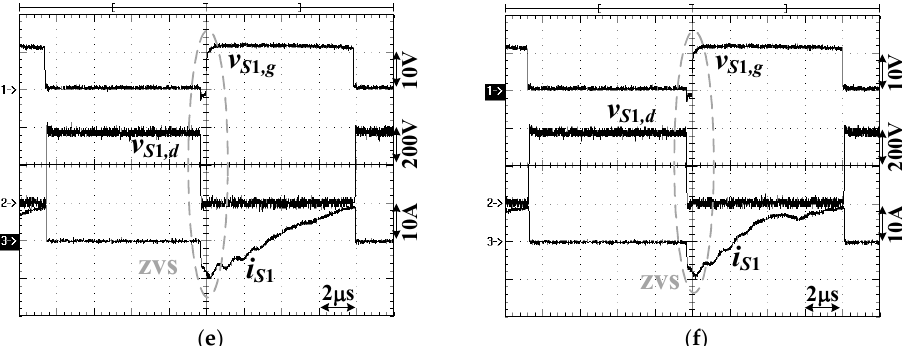
Figure 11. Experiments of the presented converter under V o = 160 V: ( a ) v S 1 ,g , v S 2 ,g , v S 3 ,g , and v S 4 ,g under V in = 760 V and P o = 1 kW; ( b ) v S 1 ,g , v ab , and v bc under V in = 760 V and P o = 1 kW; ( c ) v Cr 1 , v Cr 2 , and i Lr under V in = 760 V and P o = 1 kW; ( d ) I o , V o , i D 1 , and i D 4 under V in = 760 V and P o = 1 kW; ( e ) v S 1 ,g , v S 1 ,d , and i S 1 under V in = 760 V and P o = 200 W; and ( f ) v S 1 ,g , v S 1 ,d , and i S 1 under V in = 760 V and P o = 1 kW.